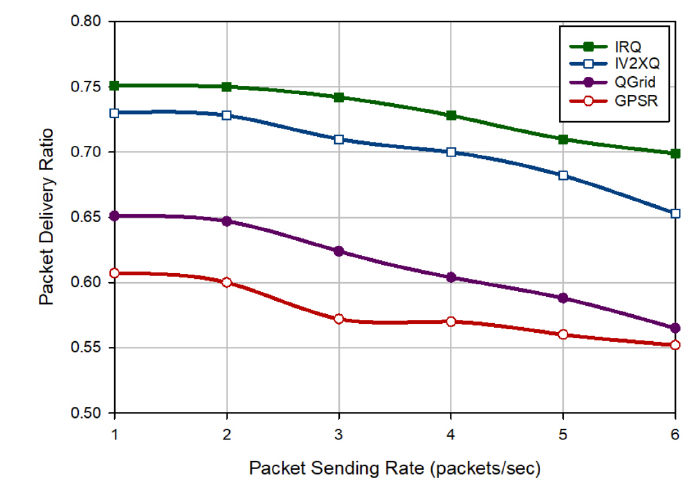
Figure 4. Comparison of PDR in different routing methods based on PSR.